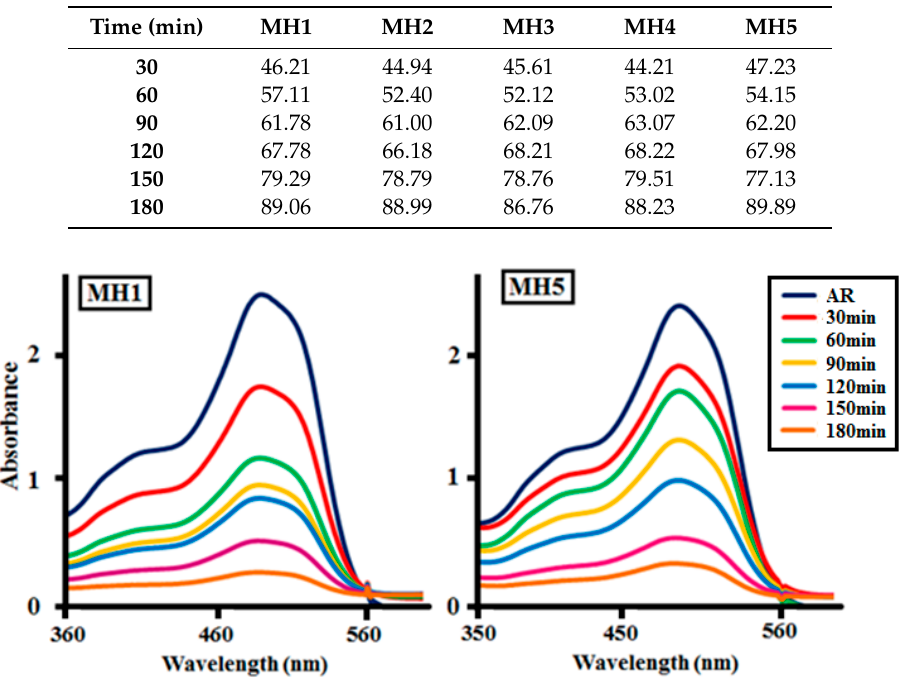
Table 5. Photocatalytic degradation of alizarin red (AR) dye (250 ppm) by MH1–MH5 (0.025 g) at di ff erent time intervals.